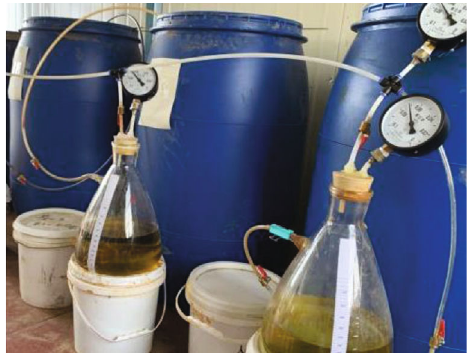
Figure 3: Physical diagram of the test